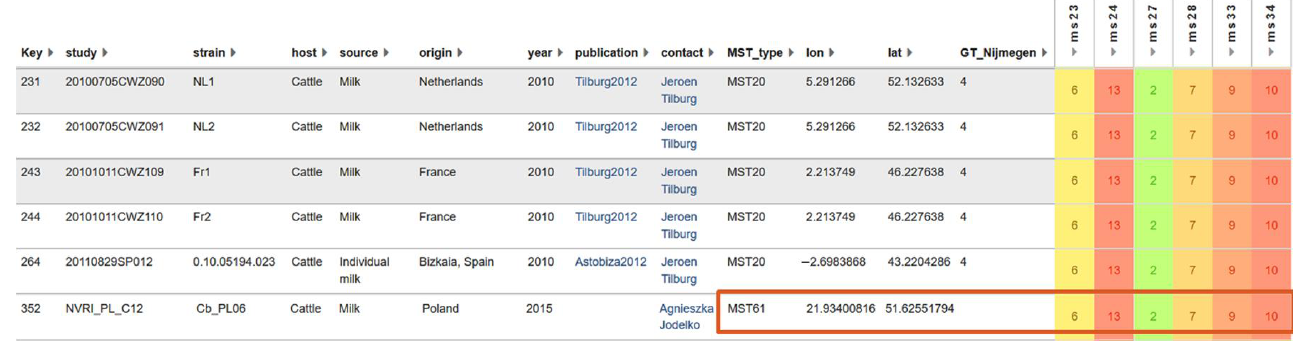
Figure 3. Identification of MLVA type of C. burnetii detected in South Korea. Six markers (MS23, MS24, MS27, MS28, MS33, and MS34) of MLVA of C. burnetii identified in South Korea were compared with the MLVA database. Strains identified in the Netherlands, France, Spain, and Poland showed the same MVLA type, of which the strain Cb_PL06 had the same MST (MST61) and MLVA type with the strain identified in South Korea (marked in the red box).